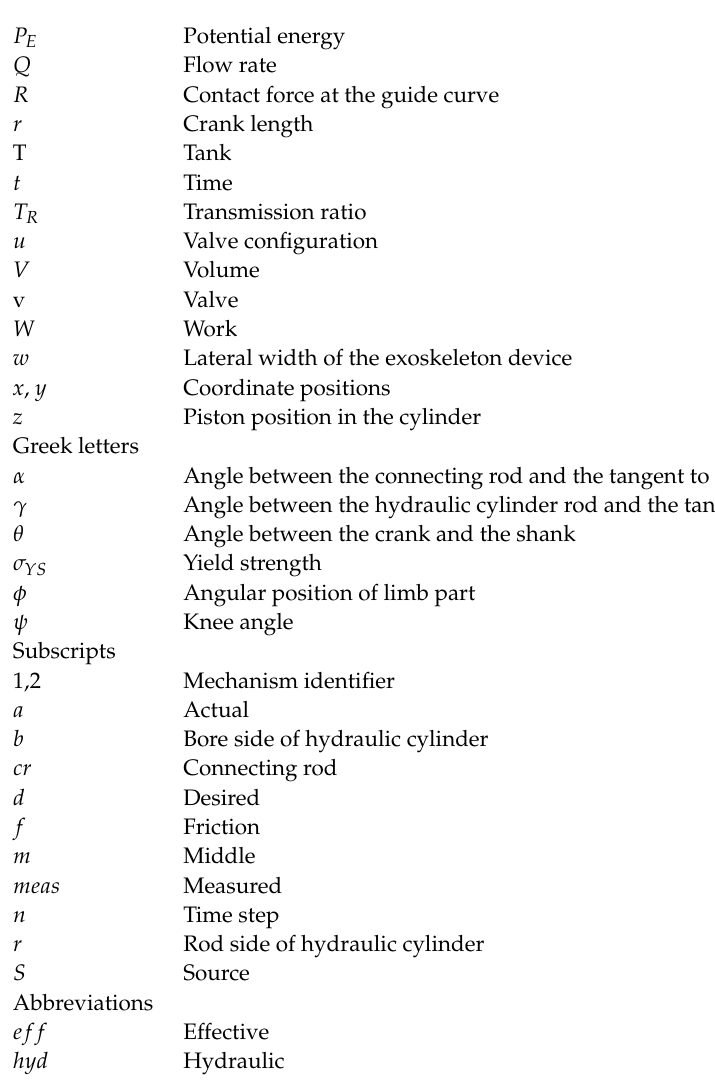
Angle between the connecting rod and the tangent to the guide curve Angle between the hydraulic cylinder rod and the tangent to the guide